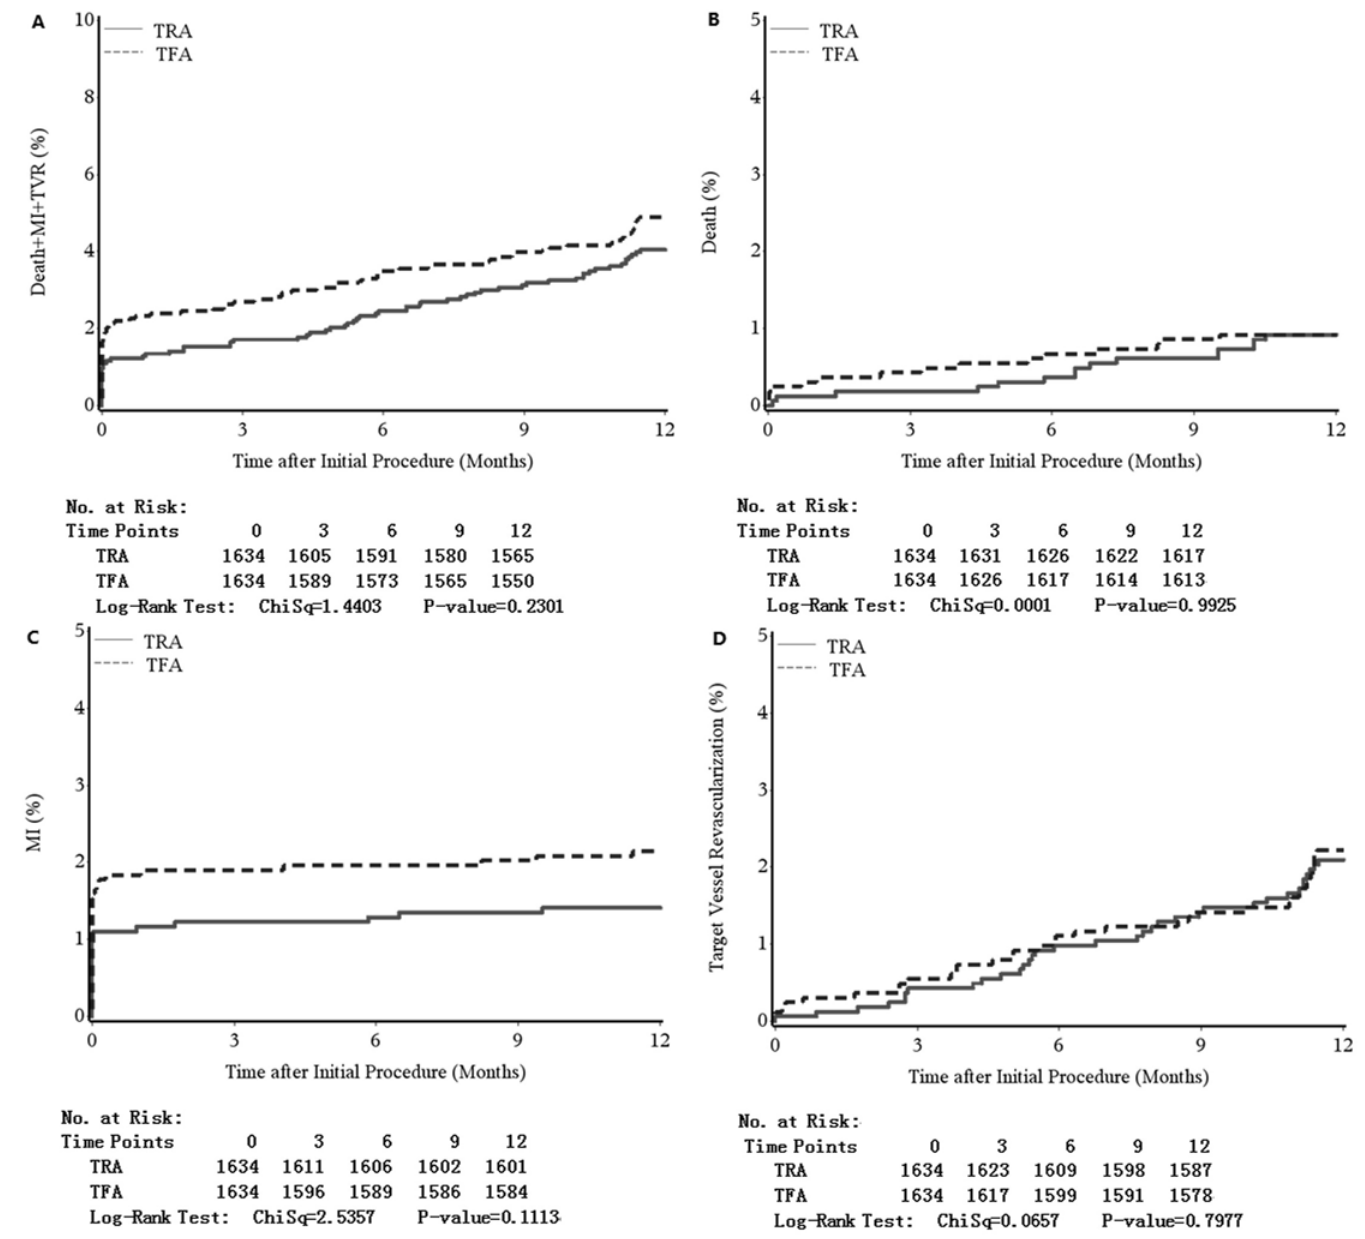
Fig 2. Kaplan-Meier curves for the outcomes between transradial and transfemoral groups of 12 months follow-up in the propensity score- matched patients. (A) Kaplan-Meier curves for occurrence of death between transradial and transfemoral groups of 12 months follow-up in the propensity score-matched patients. (B) Kaplan-Meier curves for occurrence of myocardial infarction between transradial and transfemoral groups of 12 months follow- up in the propensity score-matched patients. (C) Kaplan-Meier curves for occurrence of target vessel revascularization between transradial and transfemoral groups of 12 months follow-up in the propensity score-matched patients. (D) Kaplan-Meier curves for occurrence of major adverse cardiovascular event between transradial and transfemoral groups of 12 months follow-up in the propensity score-matched patients. MI, myocardial infarction; TFA, transfemoral approach; TRA, transradial approach; TVR, target vessel